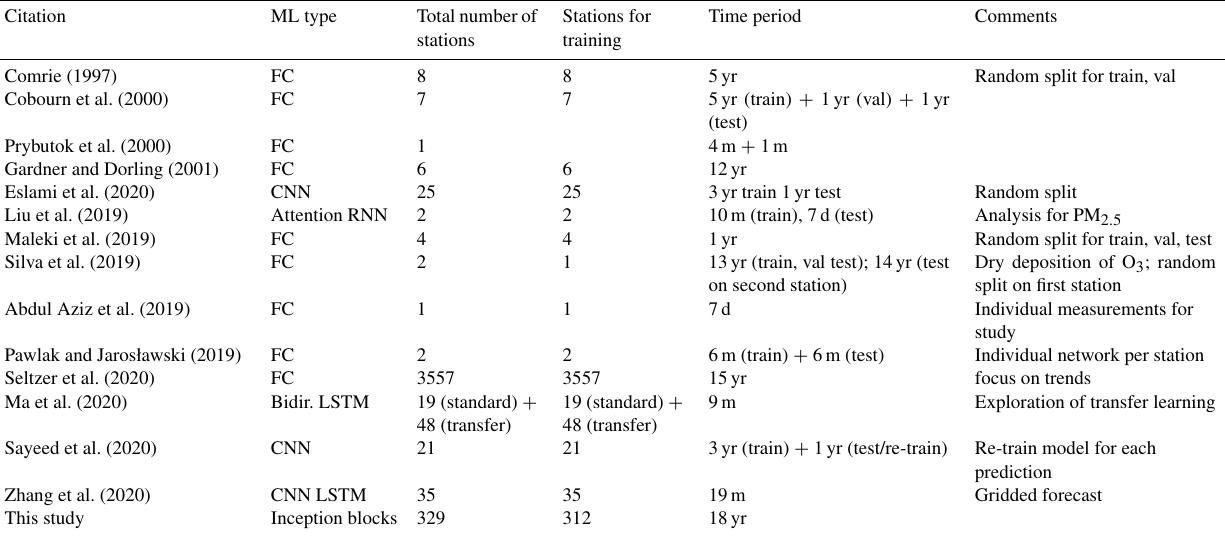
Table 1. Overview of the literature on ozone forecasts with neural networks. Machine learning (ML) types are abbreviated as FC for fully connected, CNN for convolutional neural network, RNN for recurrent neural network, and LSTM for long short-term memory. We use the following abbreviations for time periods: yr for years and m for month.